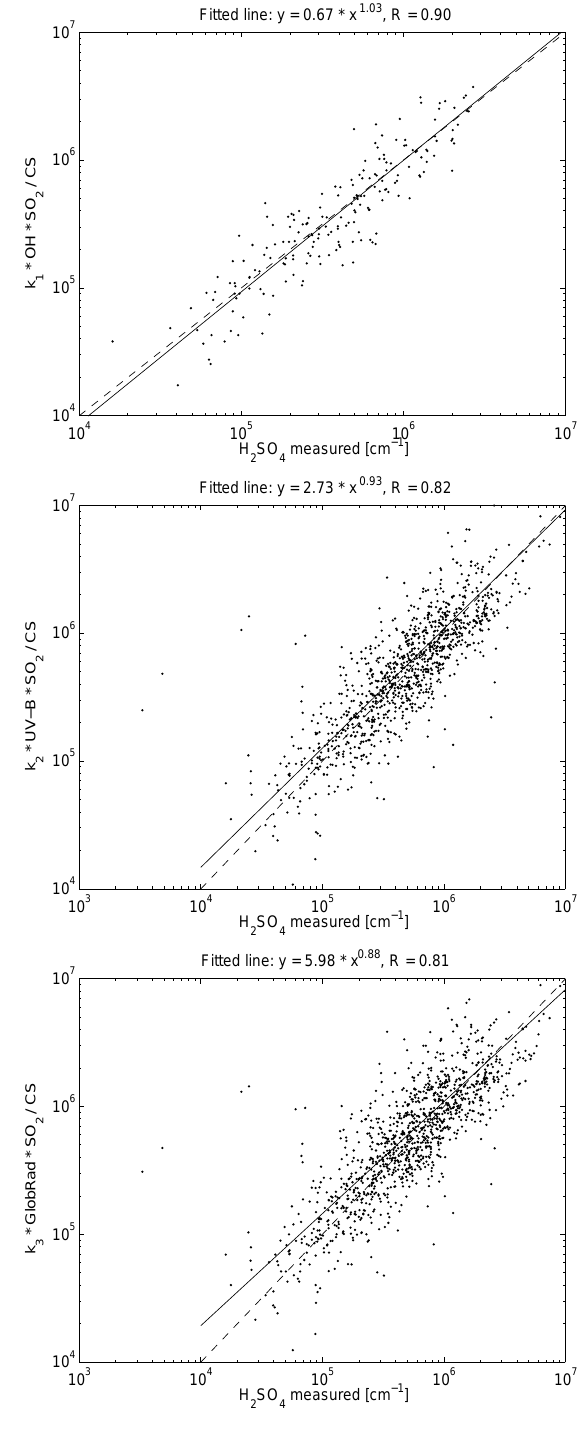
Fig. 3. Correlation and bivariate fits of measured sulfuric acid concentration and proxy utilizing a) measured OH-concentrations, b) UV-radiation and c) global radiation. Blue line is 1:1 line, black line is fitted to data set, which considers only day-time data.